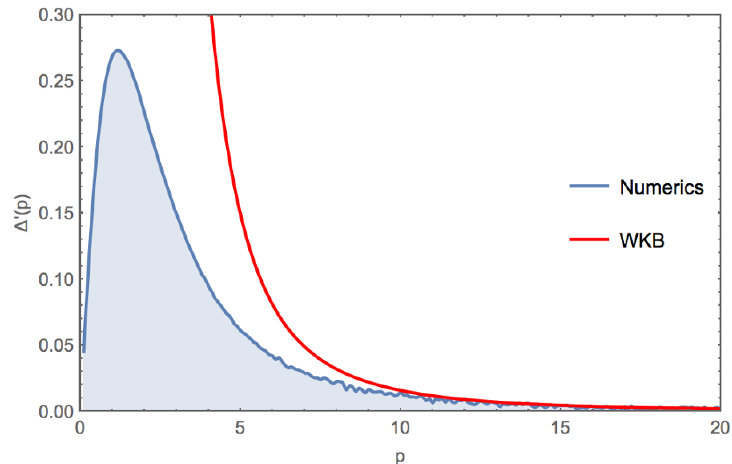
Figure 2 . The integrand (cid:1) 0 as a function of p and the corresponding WKB result from (E.4). The area under the curve, (cid:1), is given in equation